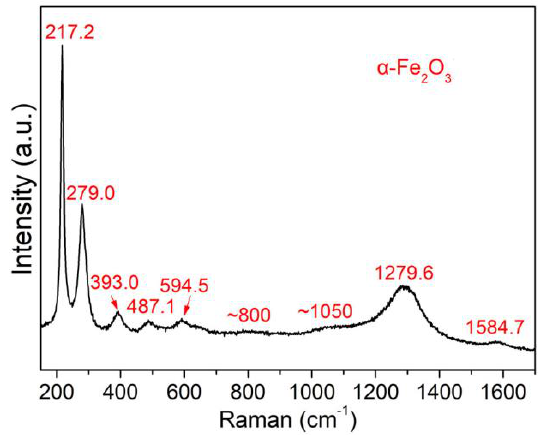
Figure 5. Raman spectrum of the particles obtained by the laser ablation in liquids (LAL) of Fe in acetone.